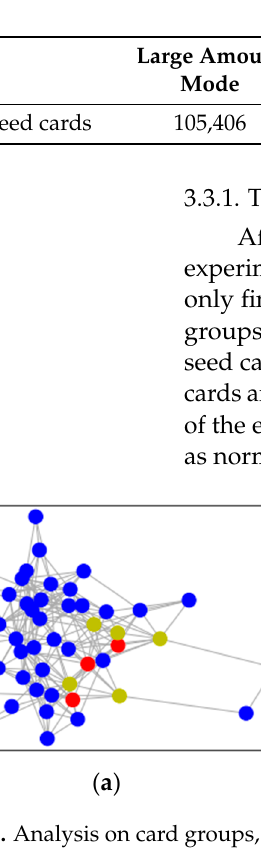
Table 5. Comparison of three clustering